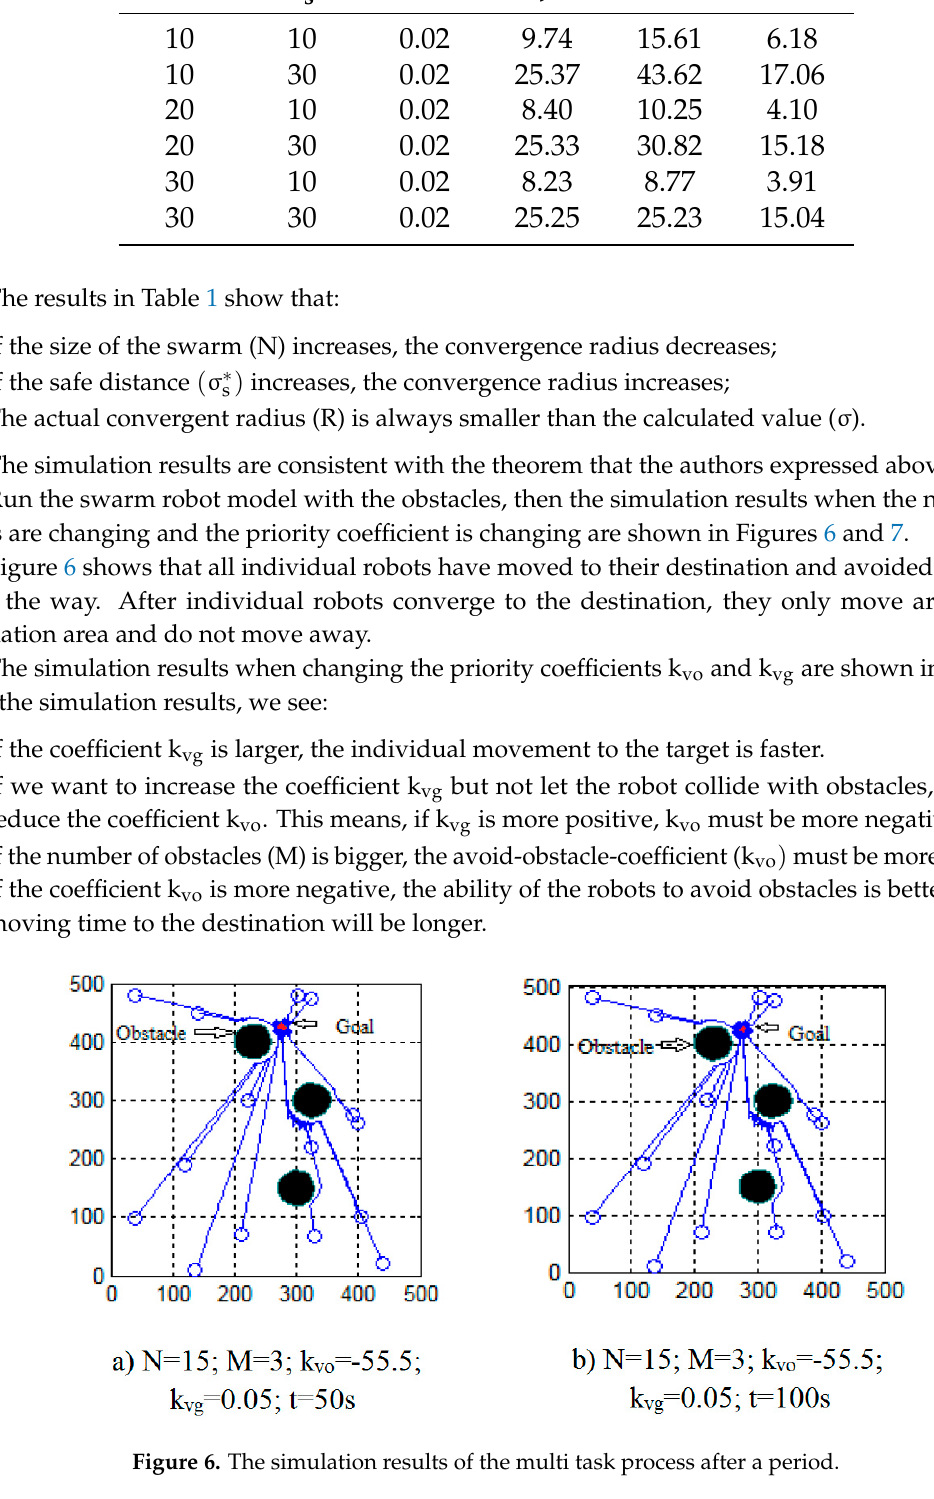
Figure 7. The simulation results of the multitask process when the coefficients k (cid:2932)(cid:2925) and k (cid:2932)(cid:2917) are changing.